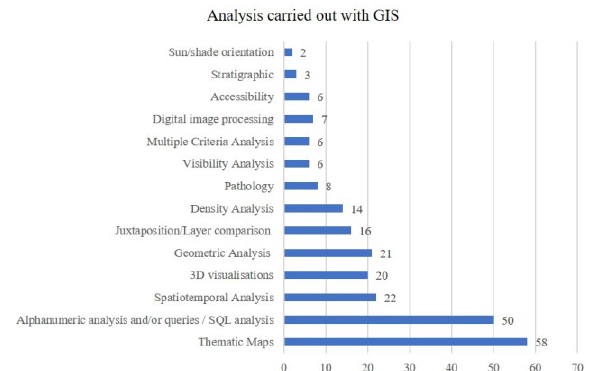
Figure 5: Types of analysis in GIS which have been done in the studies.